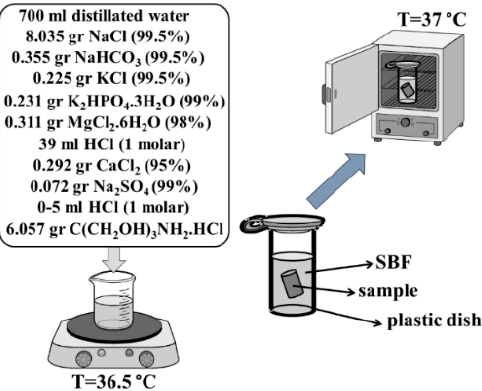
Figure 11. Synthesis route of SBF [54], immersed alloy and composites in the SBF at 37 °C. One of the most important and essential features of nanocomposites for use as bioma- terials in the body is the composition of hydroxyapatite on the surface [55]. The bioactivity of nanocomposites can be evaluated by their ability to form hydroxyapatite in SBF. Ac- cordingly, the X-ray diffractions of alloy and composites immersed in SBF are shown in Figure 12. It is clear that the intensity of the XRD pattern increases after 5, 10, 20 and 30 days. Moreover, hydroxyapatite was formed, and the X-ray diffraction corresponds to those of the cited hydroxyapatite in Ref [9]. The X-ray diffraction of alloy and composites corresponded to standard JCPDS 9–432 [56]. The characteristic main peaks at ~2 θ = 25.93 ◦ , 31.85 ◦ and 32.21 ◦ are related to planes (002), (211) and (300), respectively, showing that these angles and planes are directly attributed to hydroxyapatite [41,57]. Depending on the content of the alloy, the effect of the alloy, as well as the influence of CaO, is observed at ~2 θ = 66.39 ◦ and 71.59 ◦ in tandem.